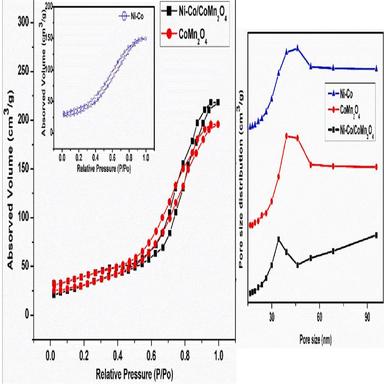
N2 absorption–desorption isotherms of designed as-prepared electrodes (Ni-Co, CoMn2O4, and Ni-Co/CoMn2O4) samples.